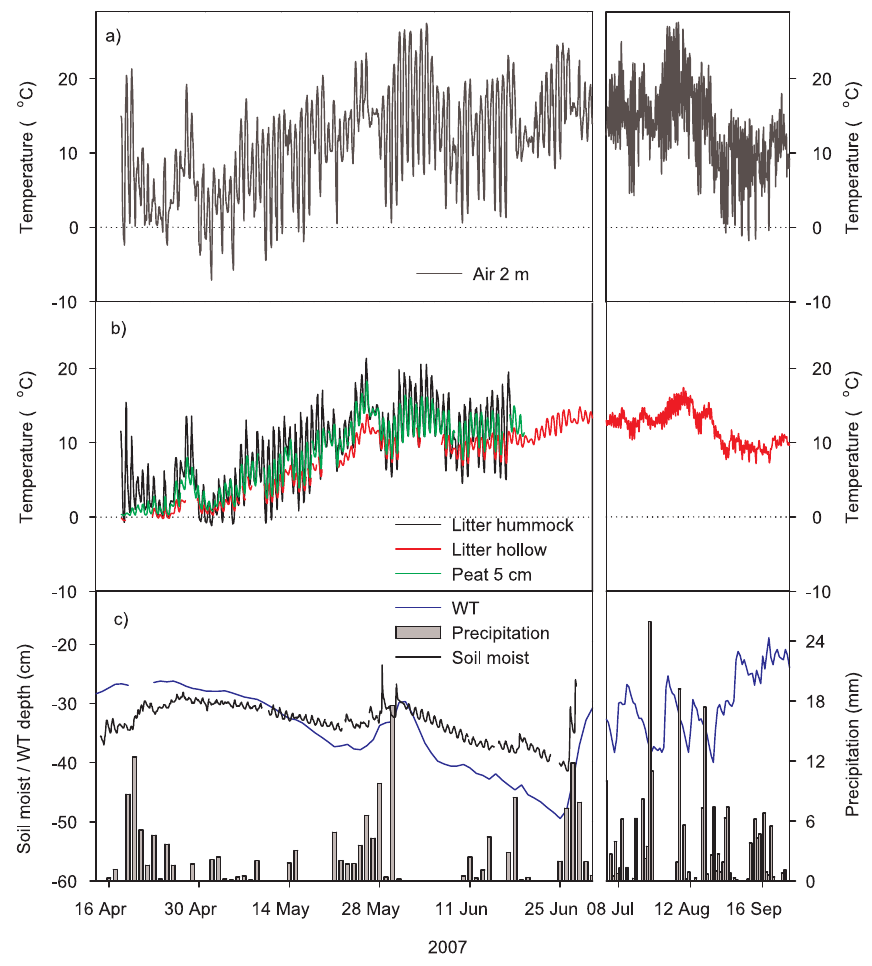
Fig. 2. (a) Air temperature, (b) soil temperatures in litter layer (hummock and hollow) and in peat, and (c) soil moisture (vol/vol), ground water table depth (WT) and precipitation at the drained peatland pine forest during April–September 2007 (intensive measurements 25 April– 27